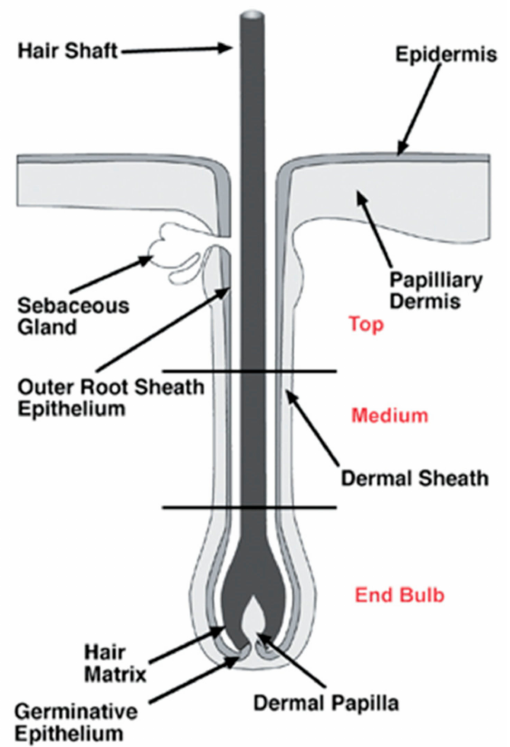
Figure 2. The anatomy of hair follicles (HFs), with the main emphasis on the end bulb and the medium and top sections of the vibrissae, which are separated by black lines. Reproduced with permission from